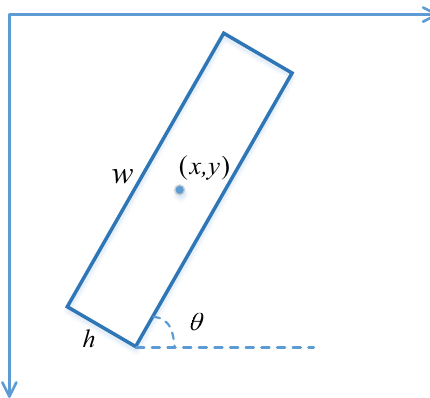
Figure 4. Representation of a rotation bounding box.